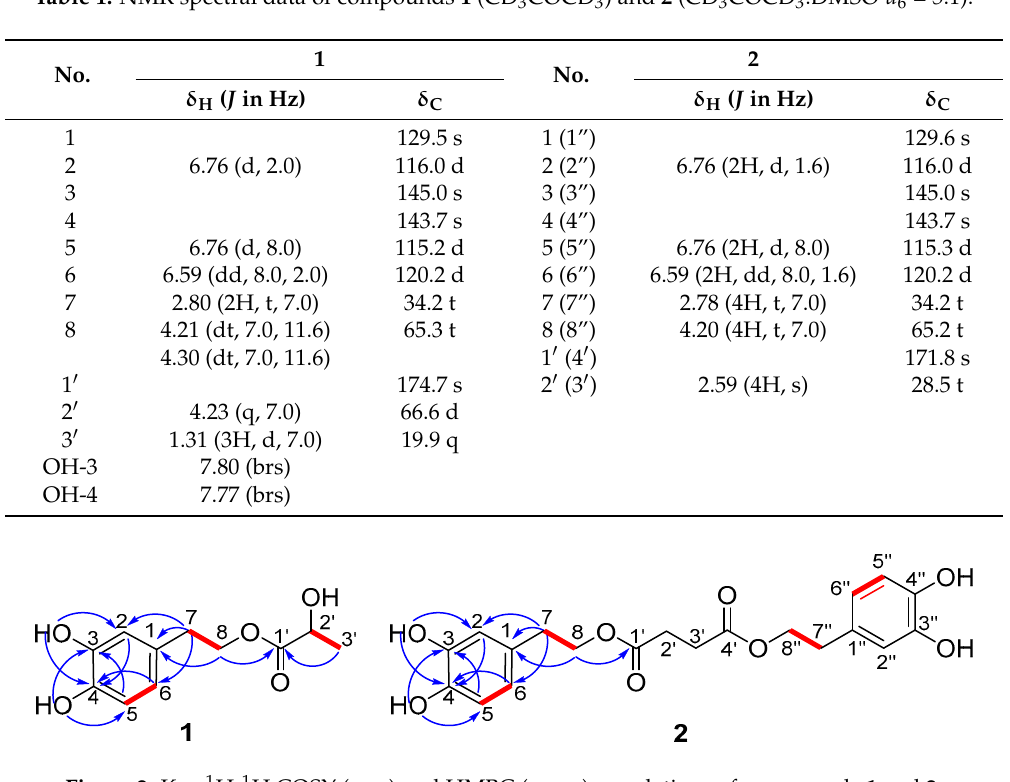
Table 1. NMR spectral data of compounds 1 (CD 3 COCD 3 ) and 2 (CD 3 COCD 3 :DMSO- d 6 = 5:1).